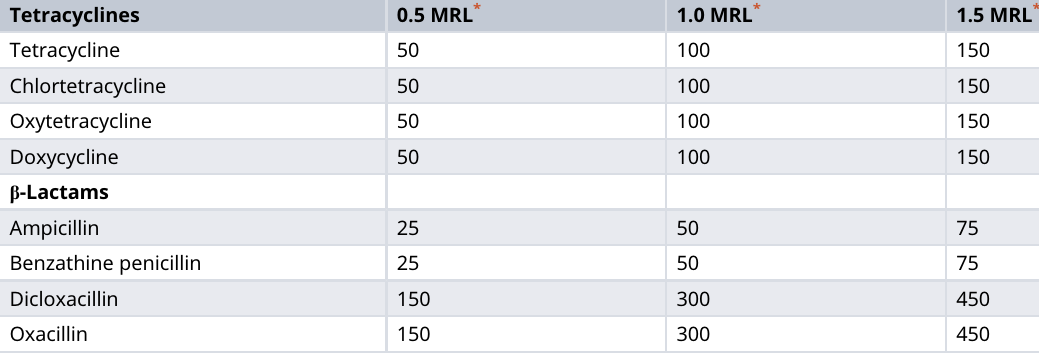
Table 1. Tetracyclines and β -Lactams concentrations at 0.5, 1.0 and 1.5